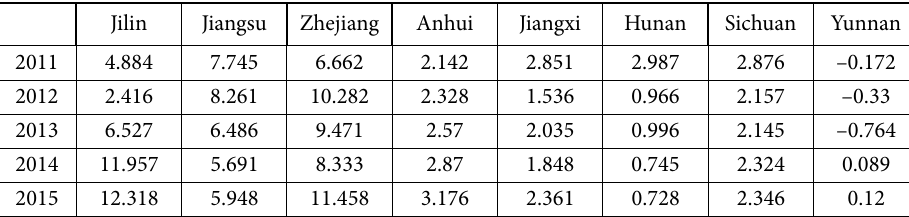
Table 9. Critical tax rate of selected regions